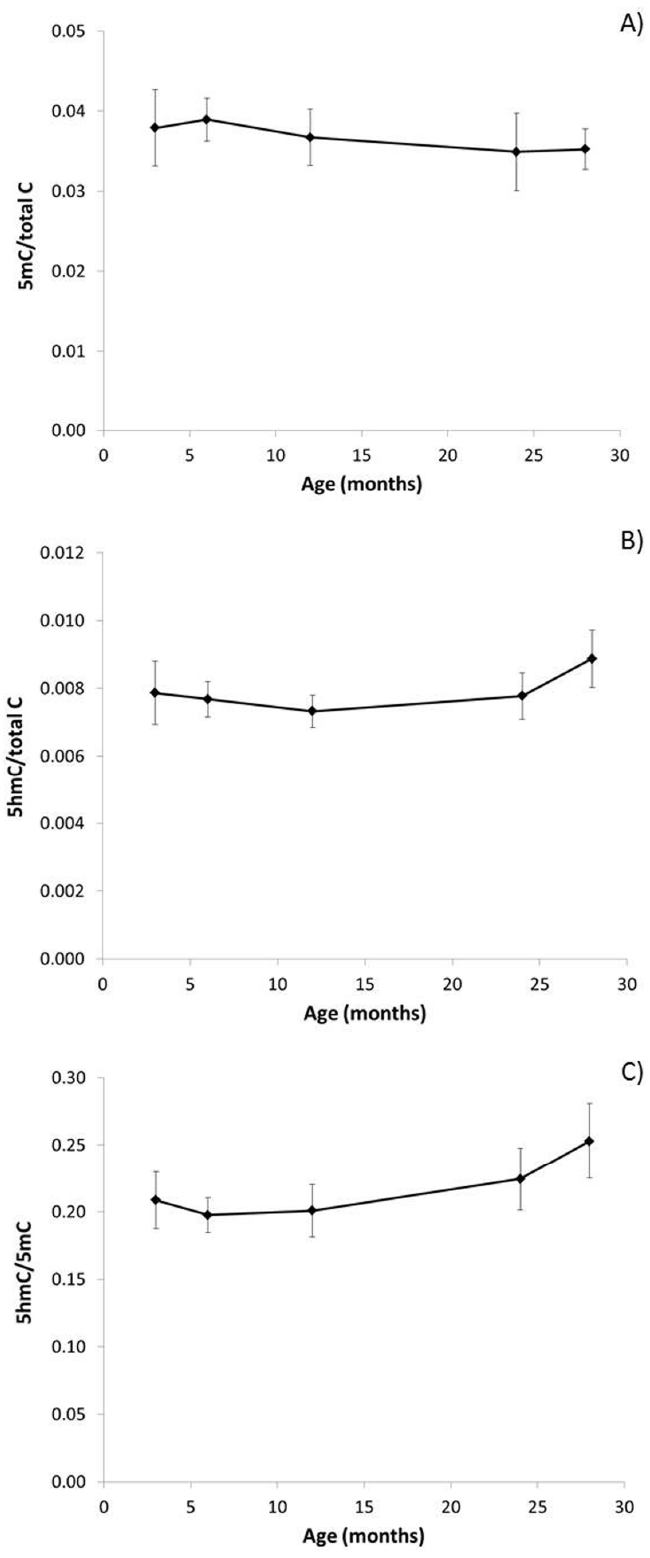
Figure 2. Effect of ageing on genomic 5mC and 5hmC levels. Levels of: ( A ) genomic 5mC over total cytosine; ( B ) levels of 5hmC over total cytosine; and ( C ) ratio of 5hmC/mC ( P ANOVA = 0.027; R 2 = 0.382, p = 0.008) in the brain of male mice. Percentages shown are calculated from the mean values ( n = 4), and error bars represent standard errors of the mean (SEM).